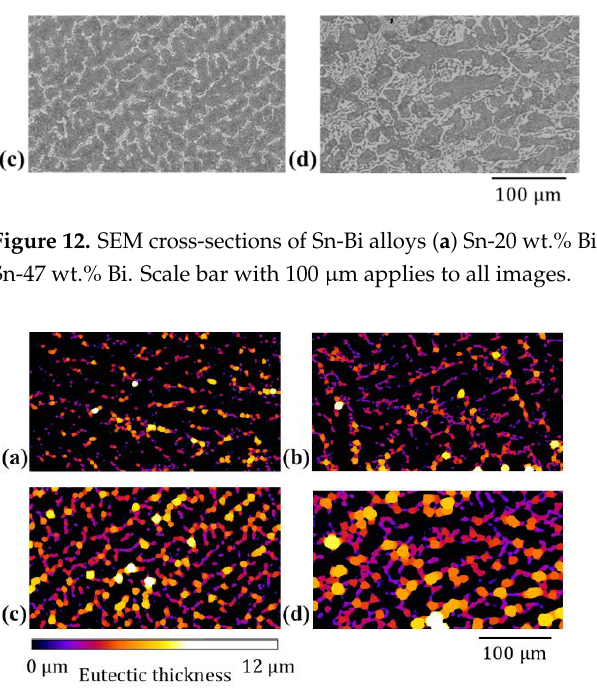
Figure 13. Local eutectic thickness map of Sn-Bi alloys ( a ) Sn-20 wt.% Bi ( b ) Sn-30 wt.% Bi ( c ) Sn-35 wt.% Bi ( d ) Sn-47 wt.% Bi. The color spectrum defines the eutectic thickness, scale bar applies on all images.